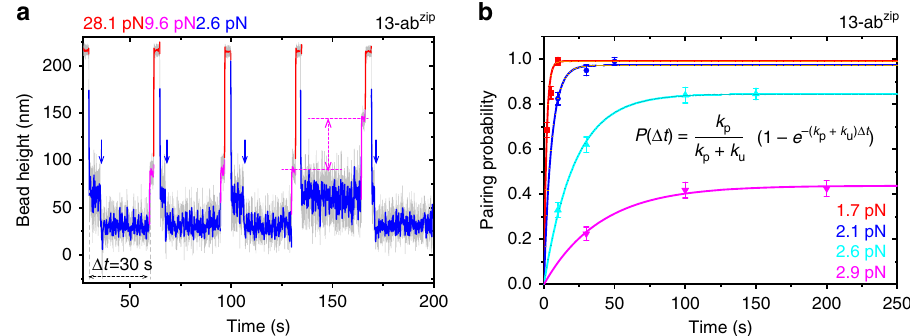
Fig. 4 Force-dependent looping rate of helix-heterotetramer. a An example of the force-clamping procedure to quantify the rate of the formation of the helix-heterotetramer in the linked construct 13-a1a2Lb1b2 at various forces. After jumping from a higher force (~28.1 pN) where the construct is in the unlooped state to a lower force (~2.6 pN), the average looping probability is measured within certain waiting time ( Δ t = 30 s) in multiple cycles. The looping transition is indicated by a stepwise bead height decrease at ~2.6 pN (blue arrows). The magenta dash lines indicate the bead height difference between looped and unlooped states at 9.6 pN (~70 nm). b Time-dependent looping probability of the construct, P ( Δ t ) at different forces indicated by different colors. The vertical error bars indicate standard errors. Colored lines represent the exponential fi tting of the pairing probability (cid:3) (cid:4) P Δ t ð Þ ¼ k p k 1 (cid:1) e (cid:1)ð k p þ k u Þ Δ t . Source data are provided in the Source Data fi p þ k u the construct prior to the force jump. By repeating the force- jumping assay over one hundred times from more than fi ve , where k p and k u are the rates of tethers, we obtained the probability of the formation of the 13- looping (13-ab zip helix-heterotetramer formation) and unlooping ab zip helix-heterotetramer at given lower forces over the waiting (13-ab zip helix-heterotetramer rupturing), respectively, which can time Δ t (Fig. 4b). be determined by fi tting to the experimentally measured time evolution of the looping probability (Fig. 4b and Supplementary Table 1).